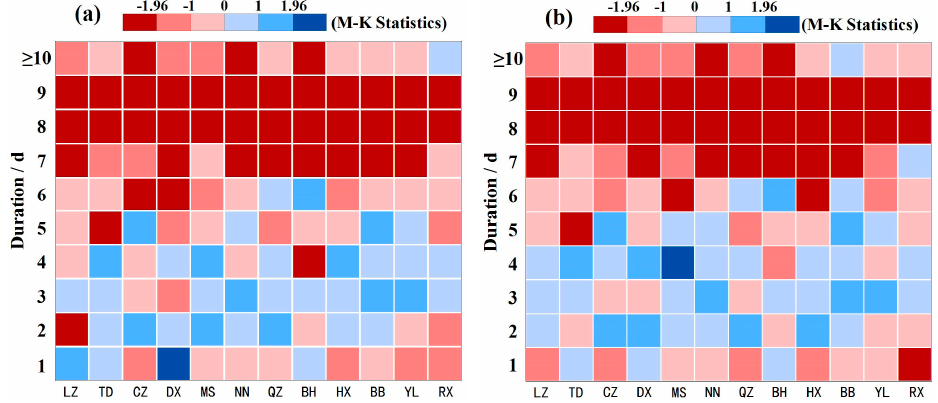
Figure 8. Variation tendency of incidence rate ( a ) and contribution rate of different durations ( b ) in rainy season at 12 stations in the Beibu Gulf. The letters along the x-axis denoted names of the precipitation stations: Longzhou (LZ), Tiandeng (TD), Chongzuo (CZ), Dongxing (DX), Mashan (MS), Nanning (NN), Qinzhou (QZ), Beihai (BH), Hengxian (HX), Bobai (BB), Yulin (YL), and Rongxian (RX).